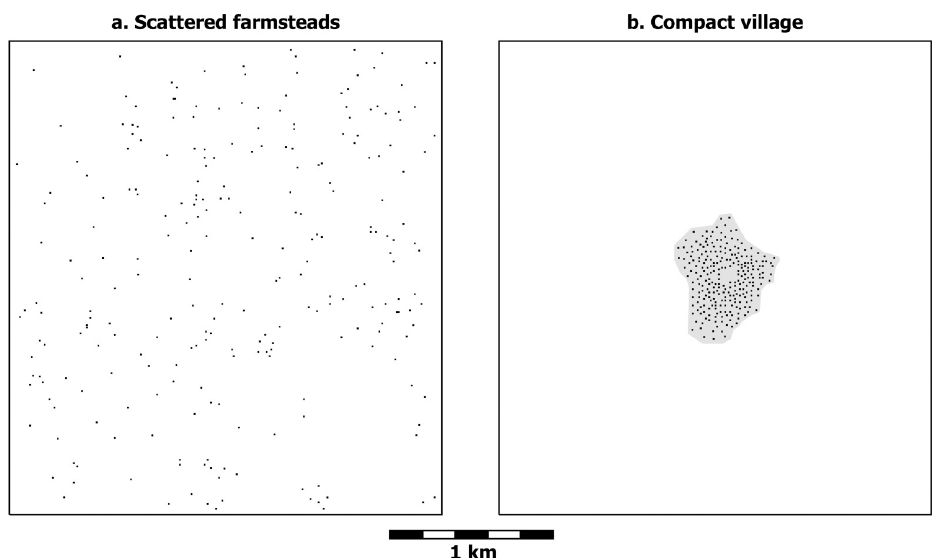
Fig 3. Hypothetical farmstead and compact village distributions. a) scattered farmsteads and b) a compact village (shown at a larger scale than Fig 2). Average nearest neighbor distance is 88 m in Fig 3A (the same as in Fig 2B) and 13 m in Fig 3B. Gray hatch in Fig 3B corresponds to the village area (30.7 ha). Both images have 250 households. Based on modern household distributions in southwestern